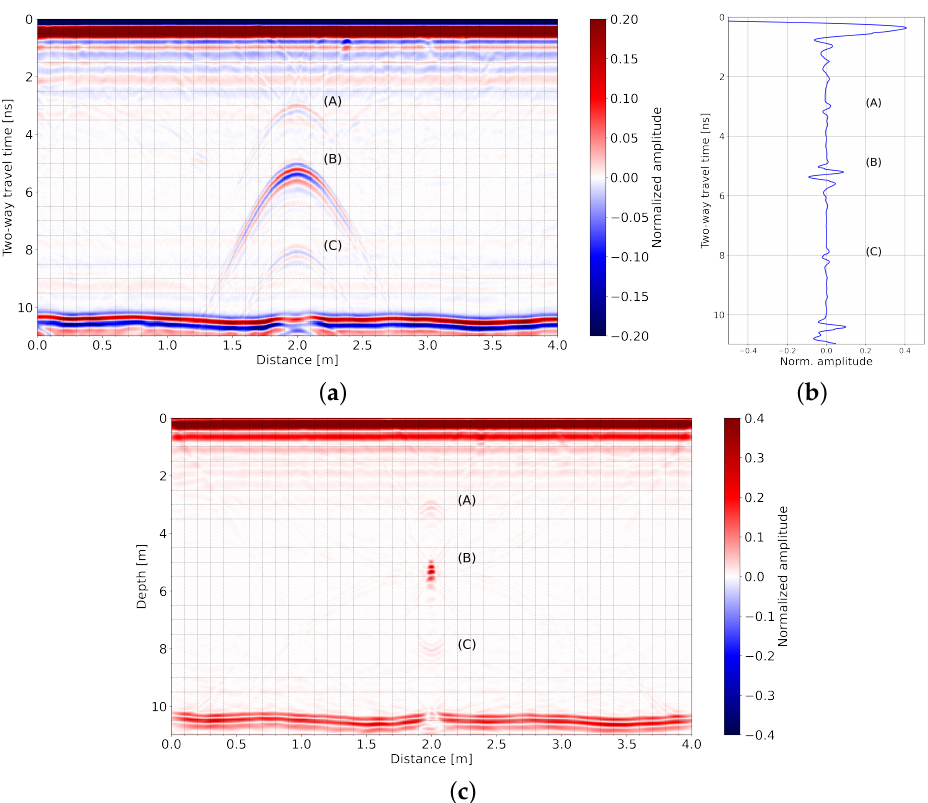
Figure 2. ( a ) Radargram acquired above the 0.12 m diameter soda lime glass sphere buried 0.3 m deep in a dry sand box (See Figure 1); ( b ) central trace acquired corresponding to 2 m distance in the radargram; ( a , c ) migrated data using a velocity of 0.16